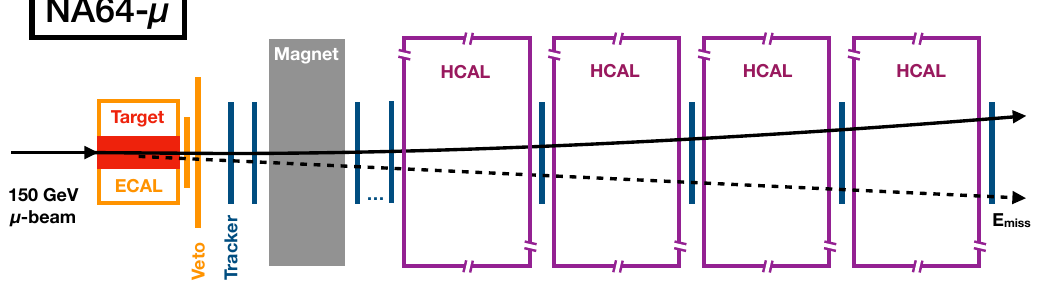
Figure 3. The detector segment of the proposed NA64- (cid:22) experimental setup. See text for more details. The full con(cid:12)guration can be found in [15,